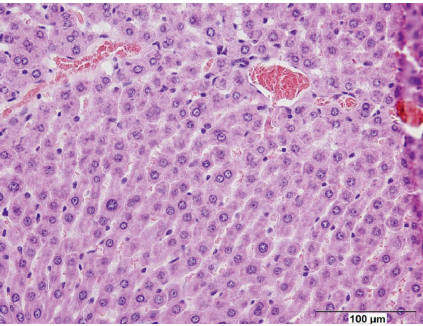
Figure 4: Binocular hepatocytes with anisocytosis (HE, x400).